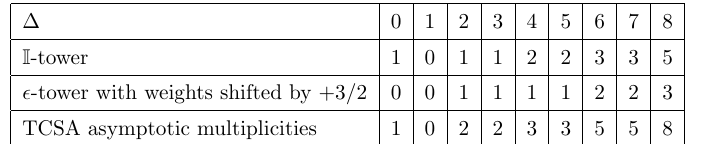
Observed multiplicities of the large coupling (cid:12)xed point with (cid:1) max = 31 : 5 ; (cid:1) 1 = 30 ; (cid:1) (cid:15) = 31 : 5 and d = 3 = 2.